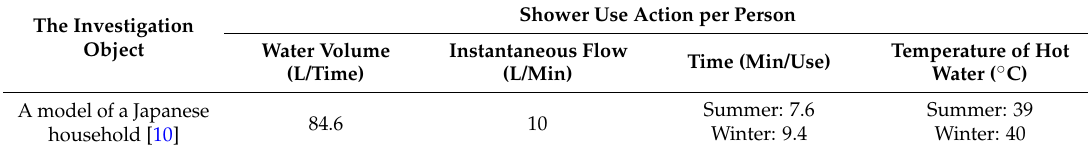
Table 9. Showering habits in Japan.